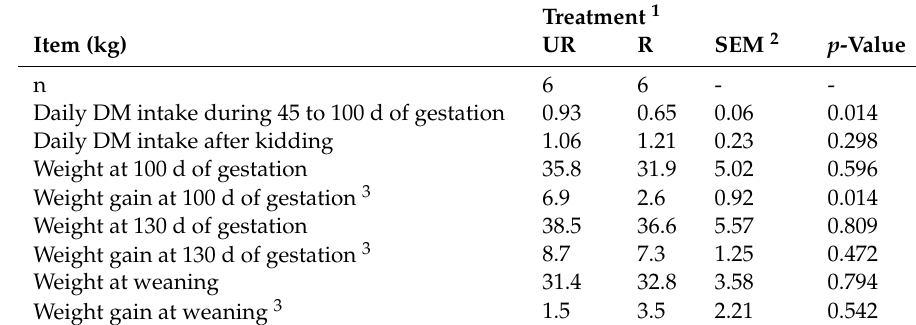
Table 3. E ff ects of undernutrition during mid-gestation on DM intake, body weight and weight gain of dams.